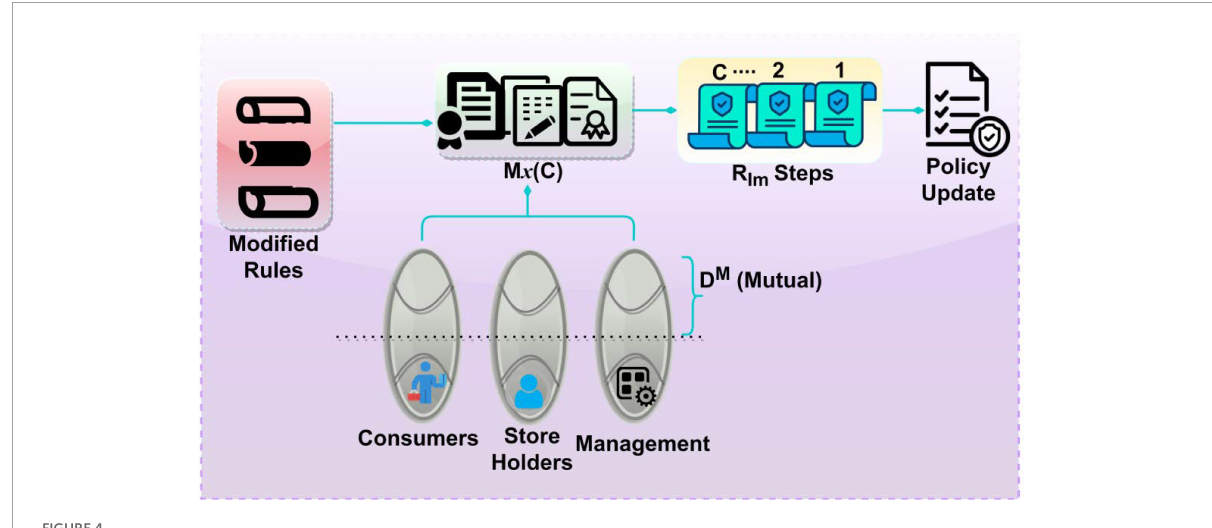
FIGURE4 Policy management from decision-making and rule